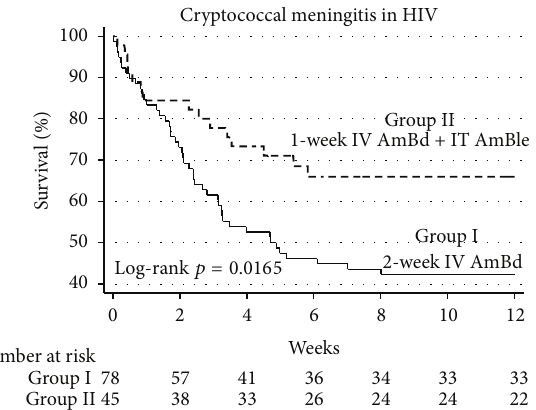
Figure 1: Kaplan-Meier survival estimates by treatment group. IV AmBd, intravenous amphotericin B deoxycholate. IT AmBle, intrathecal amphotericin B lipid